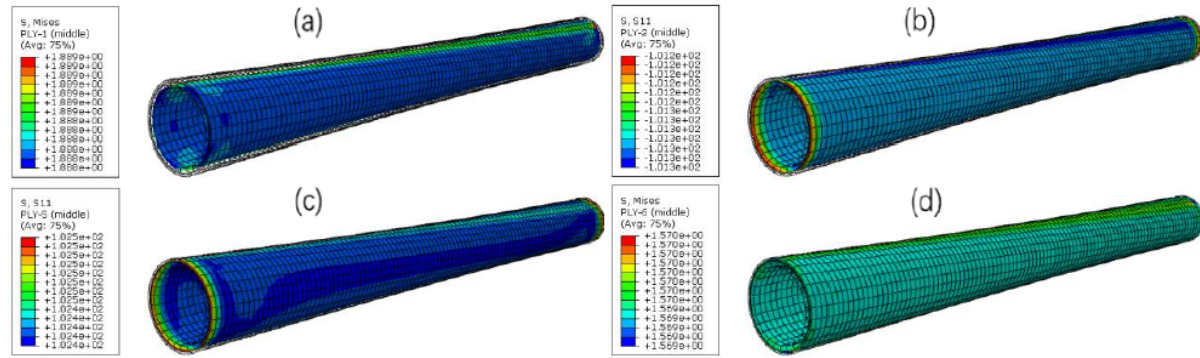
Figure 12. Stress distributions of each layer of the RTP at the torsion load of 0.2 rad: ( a ) liner; ( b ) the first reinforced layer; ( c ) the fourth reinforced layer; ( d ) outer cover.